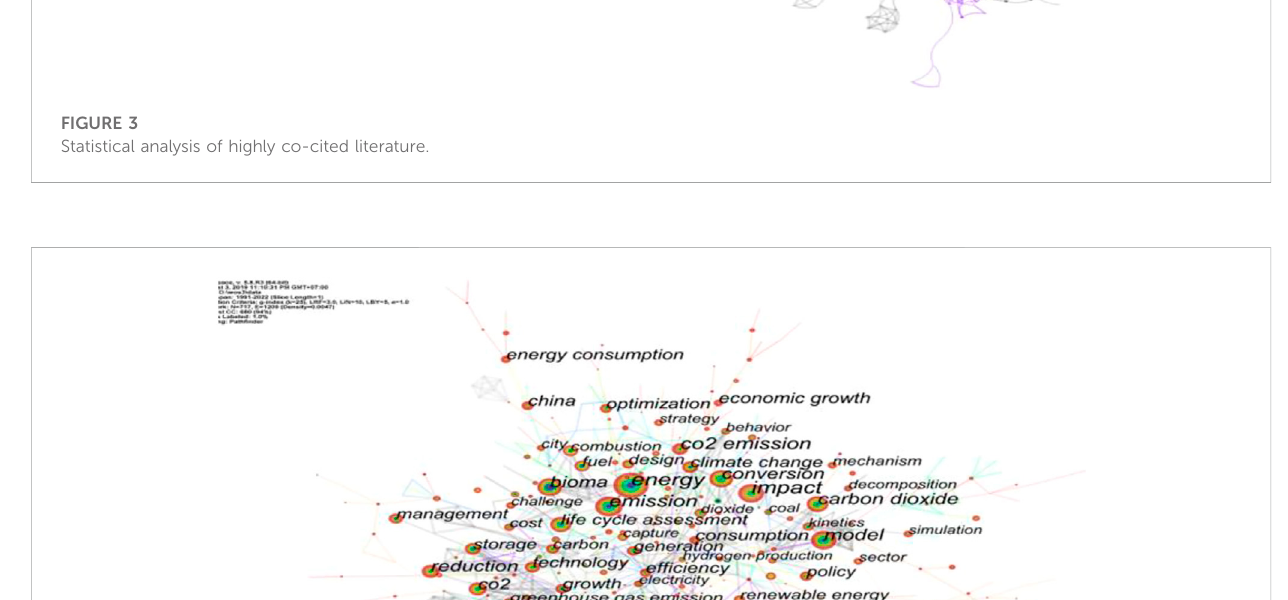
FIGURE 4 Keyword co-occurrence